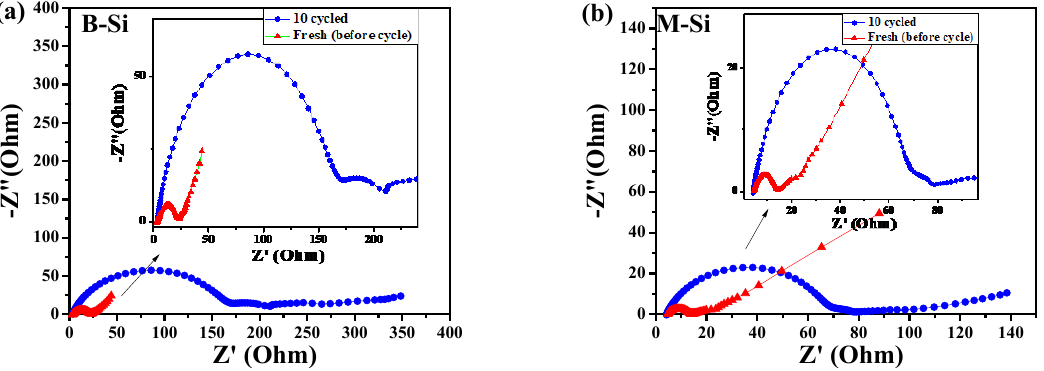
Figure 10. EIS of cells consisting of ( a ) B-Si and ( b ) M-Si material before (fresh) and after 10 cycles (de)lithiation process.